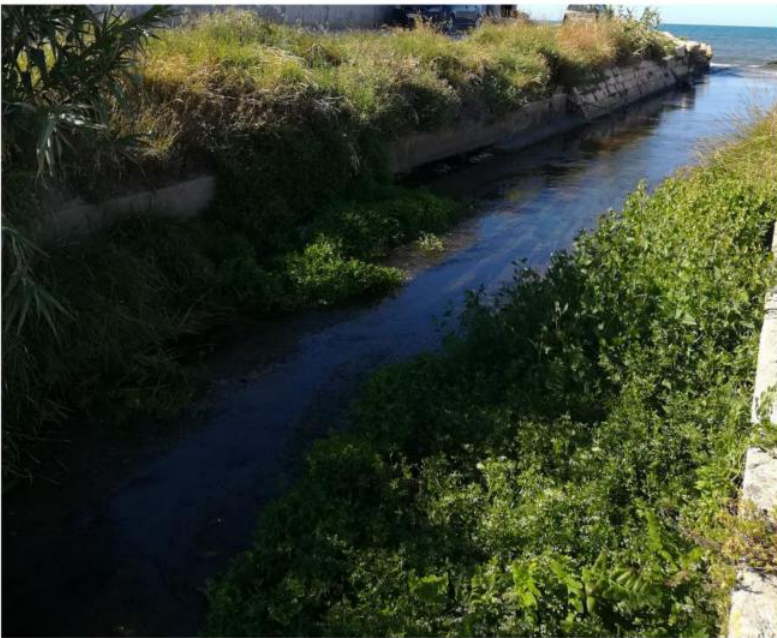
Figure 6. The drainage channel Collettore Destro at its outlet into the Adriatic